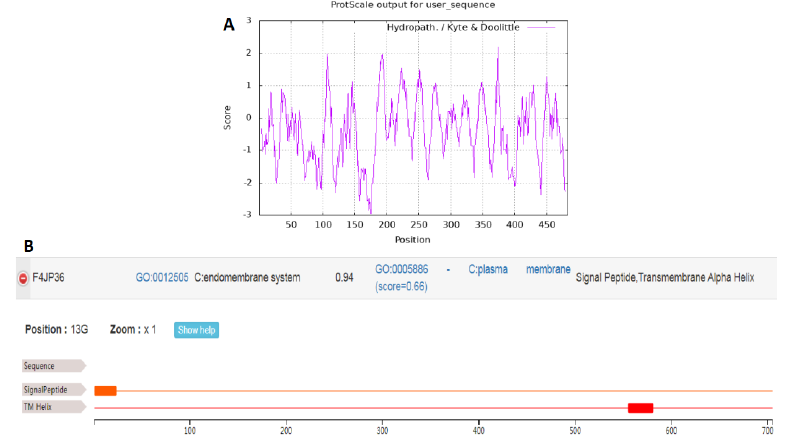
Figure 1. Hydrophobicity ( A ) and subcellular localization ( B ) of GmNAC3 protein based on ProtScale and ProtComp, respectively. The secondary and tertiary structures of the GmNAC3 protein were predicted by NetSurfP-3.0 and SWISS-MODLE, respectively (Figure 2). The results of the secondary structure of GmNAC3 protein showed that α -helix, extended chain, β -turn, and random coil accounted for 18.84%, 11.39%, 5.59%, and 64.18%, respectively, of the total amino ac- ids. The tertiary structure of the GmNAC3 protein was mainly composed of irregular coils connected by several α -helices, which was consistent with the secondary structure of the GmNAC3 protein. The conserved domain of the GmNAC3 protein was identified by SMART as the Pfam domain of the NAM subfamily, covering the amino acids at positions 6 to 132.